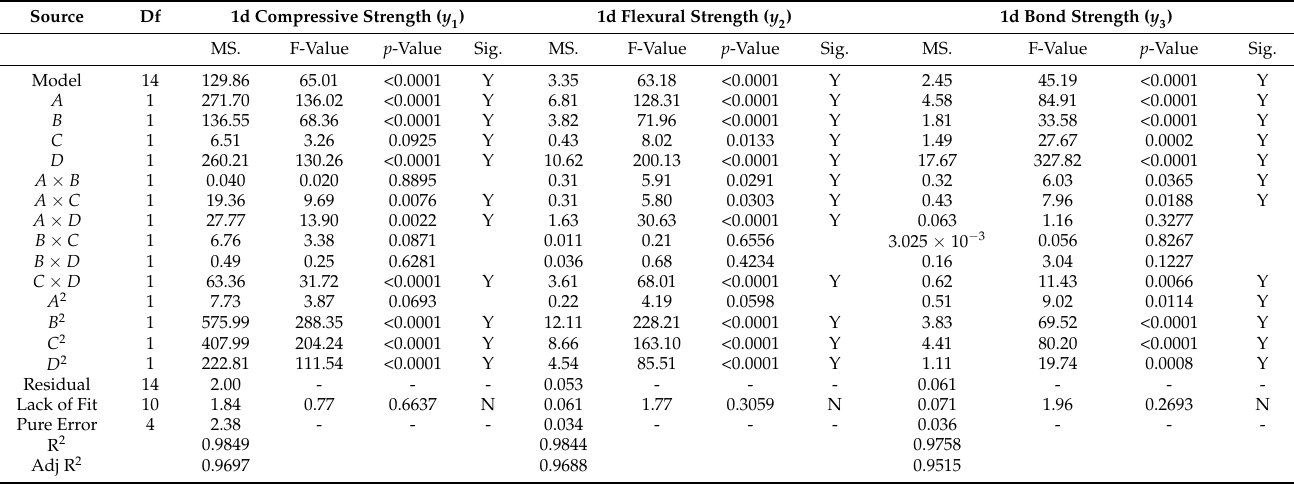
Table 7. ANOVA for the regression model and respective model